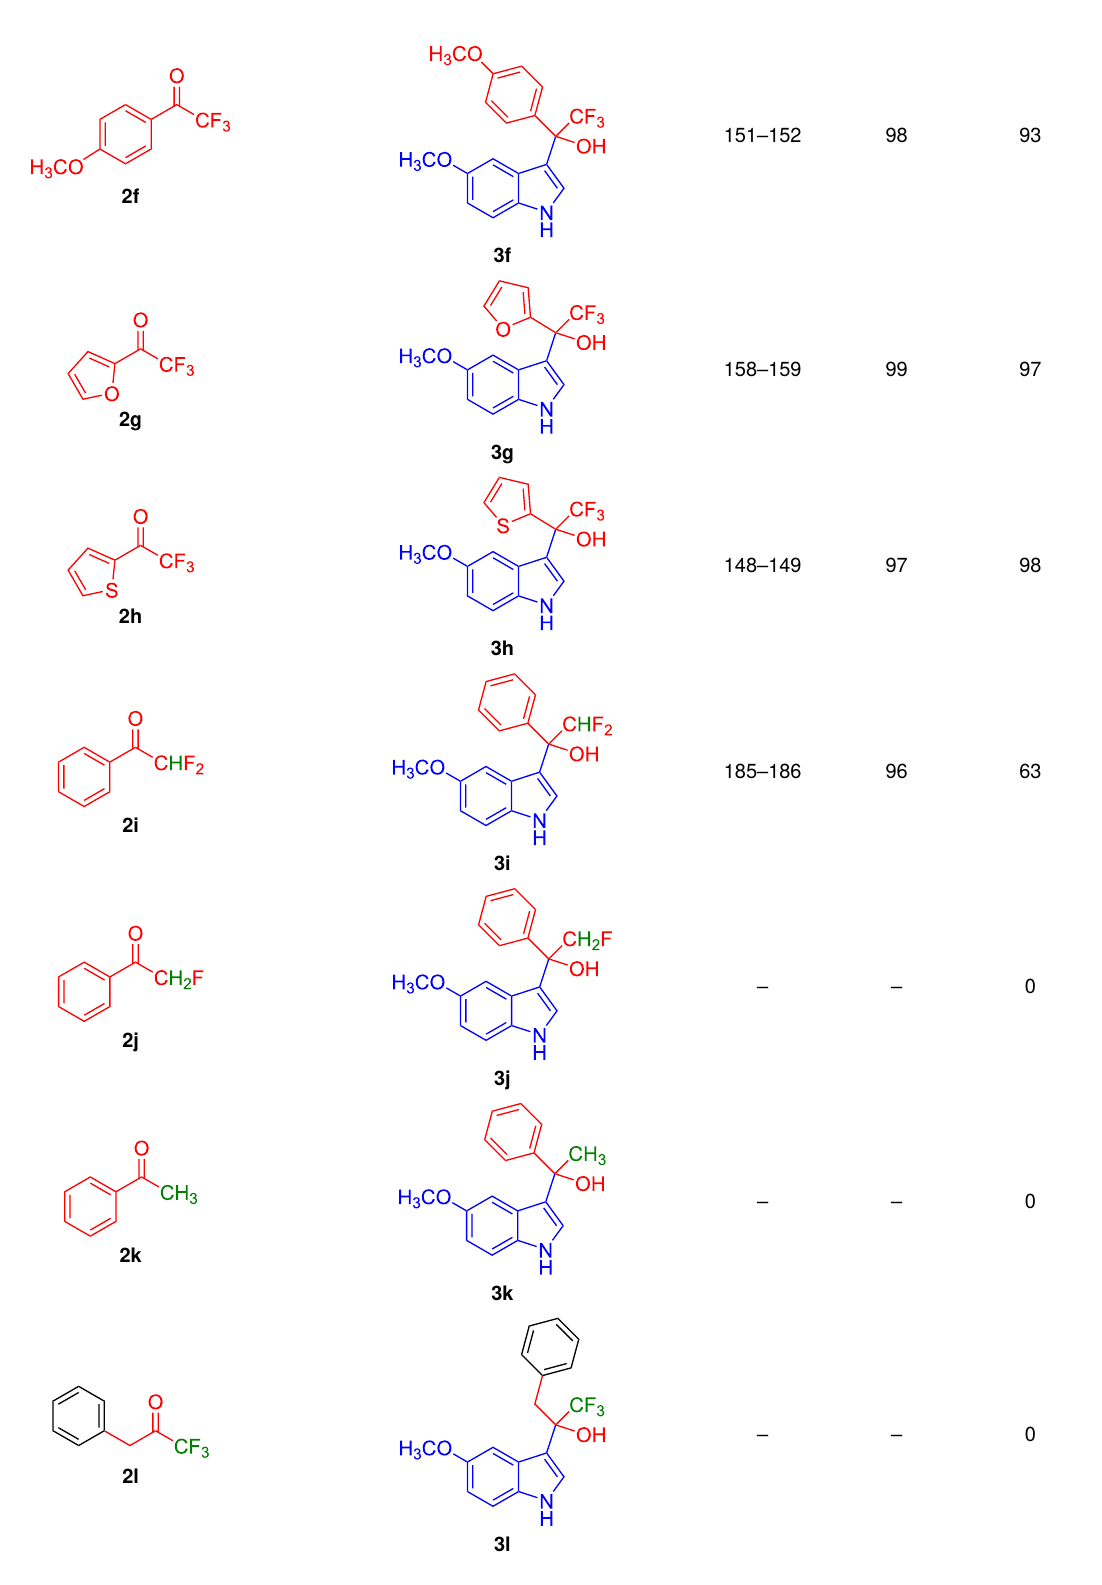
Table 2: Substrate scope of the reaction with ketones. a